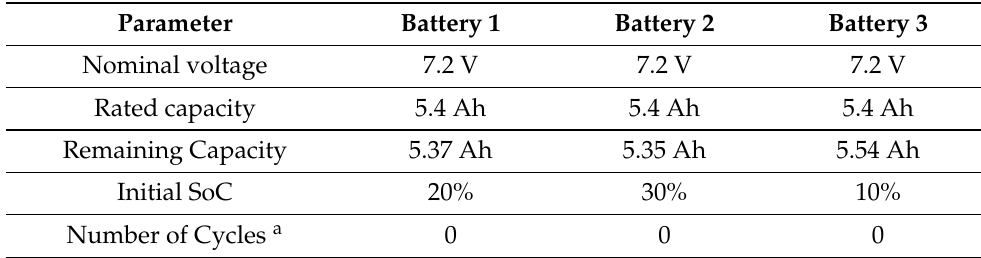
Table 2. Batteries